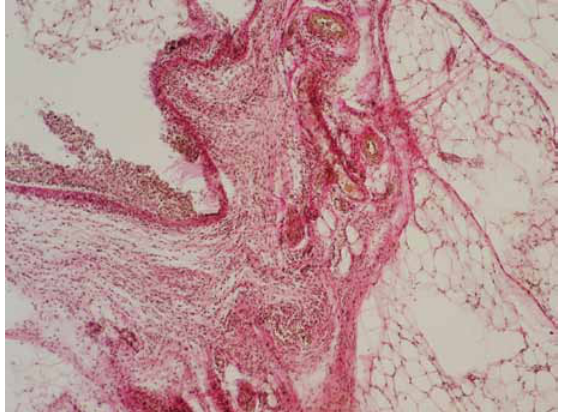
Figure 4. Photomicrography. Histiocytic reaction in mesenteric adipose tissue of the intestine, the proliferation of the